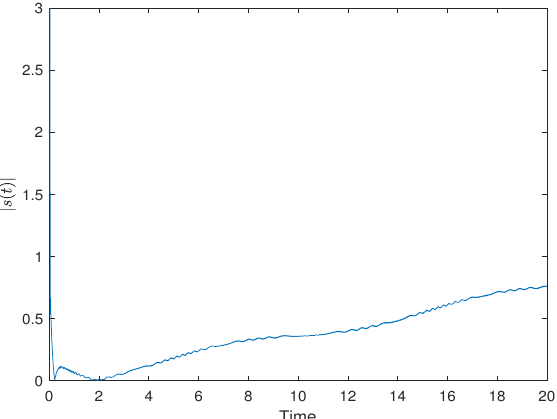
Figure 5. The sliding variable | s ( t ) | of implementing the proposed method.